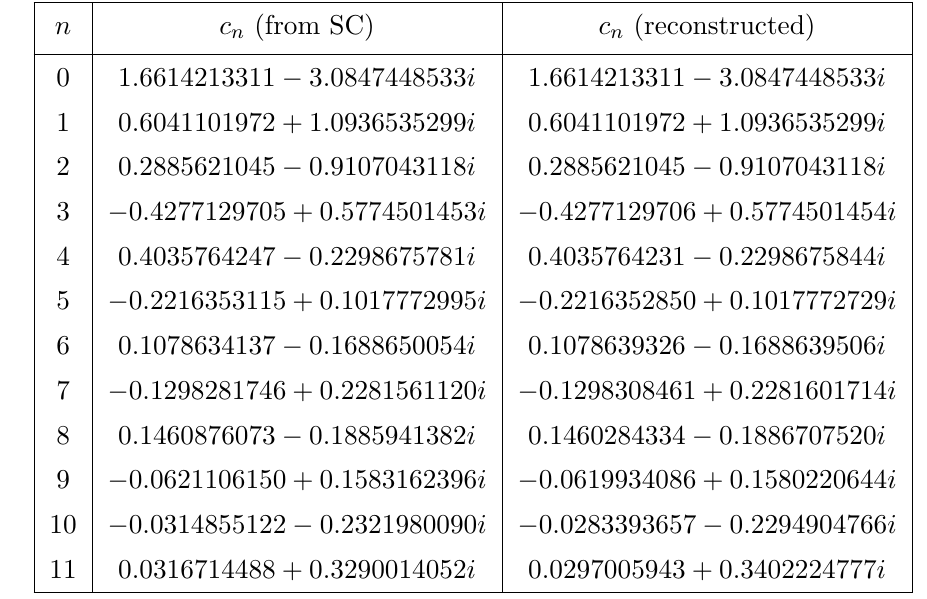
Table 4. Comparison between the N 2 = 12 coefficients c n form the series expansion of w 2 ( z ) calculated directly from the spectral curve (SC) and those reconstructed by using the Darboux